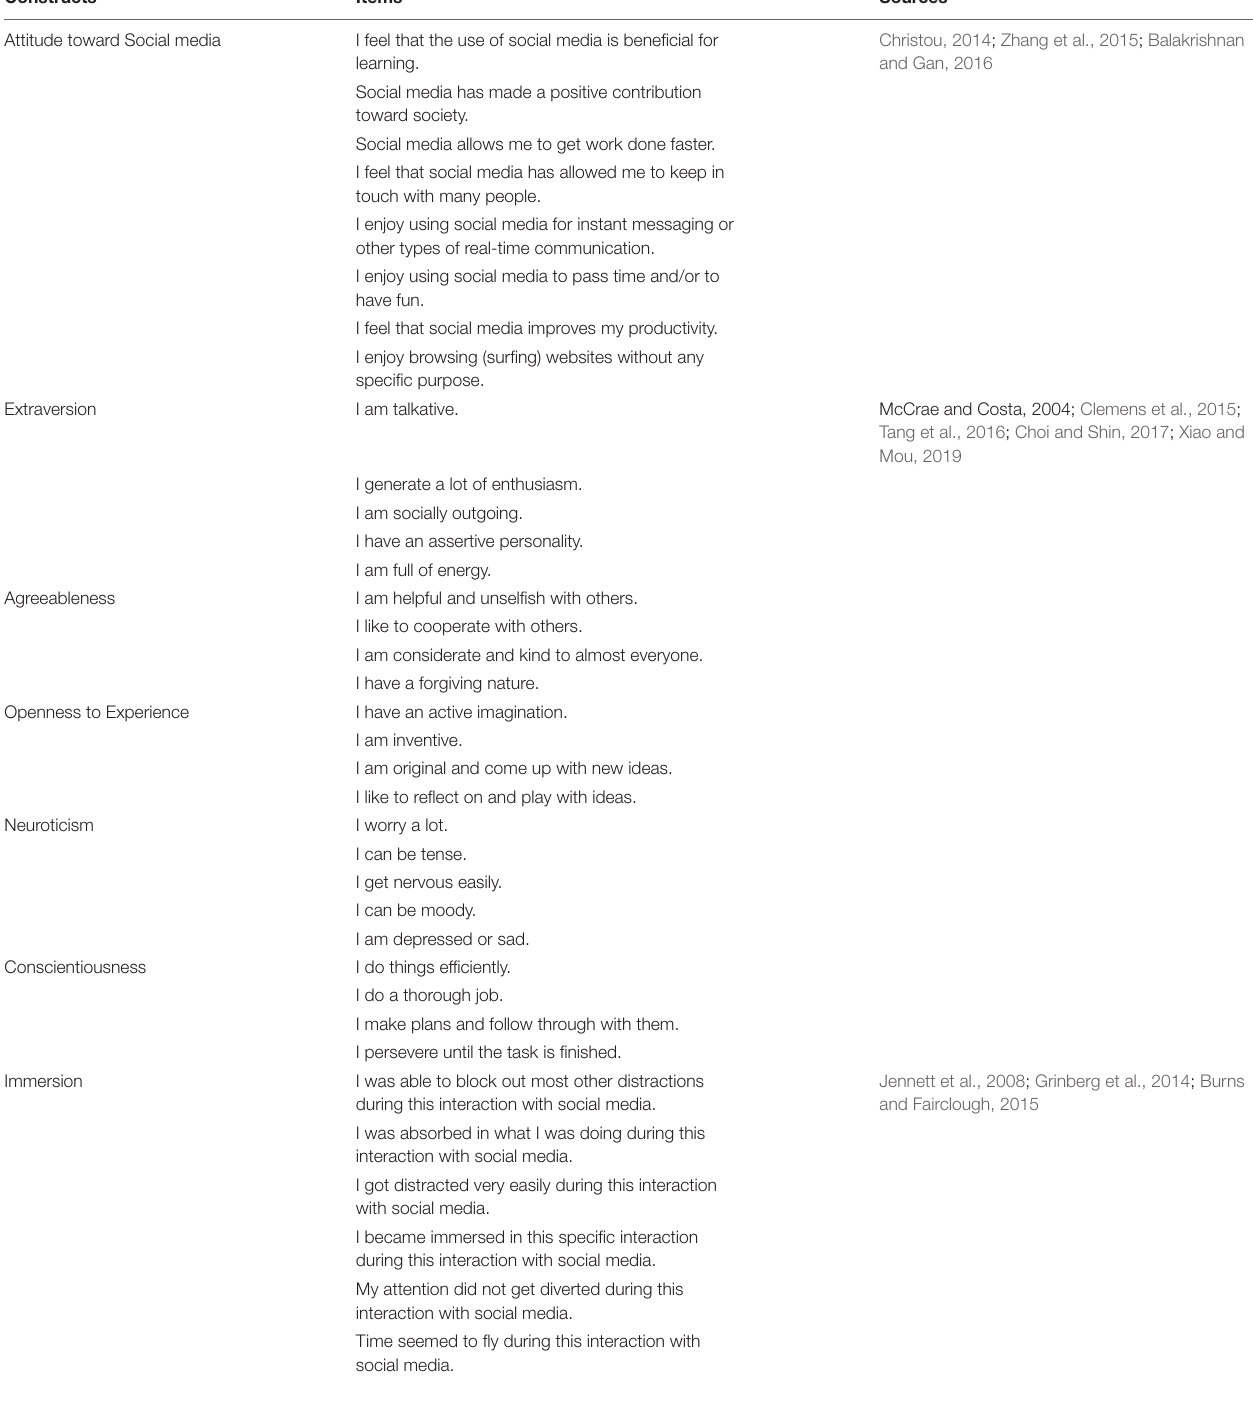
TABLE A1 | Measurement